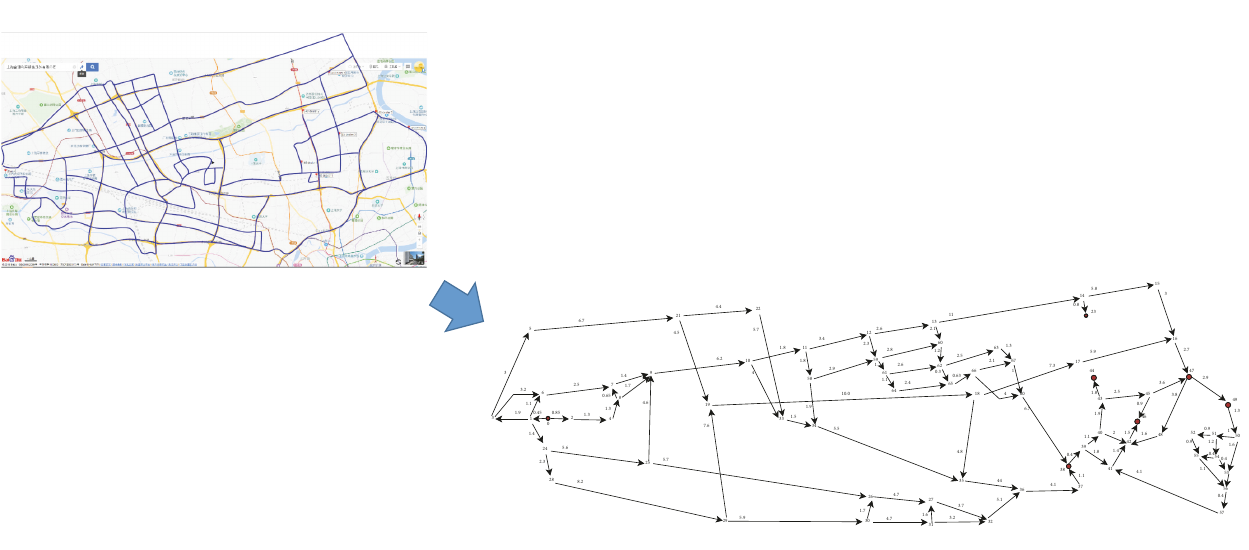
Figure 3: Creation of the simplified road map.